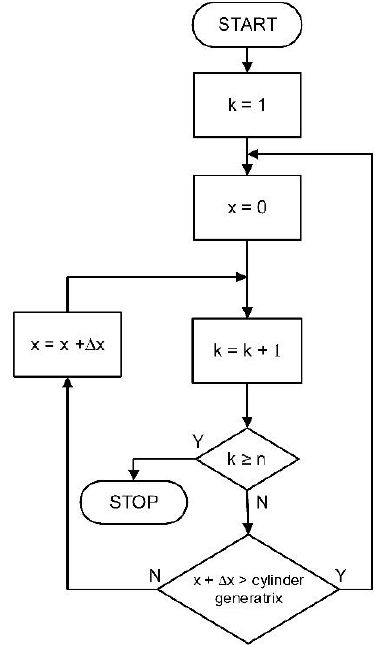
Figure 14. Flowchart of a systematic algorithm for inductor movement, where x is a coordinate along the cylinder generatrix, k is an experiment step, P is heat power, and n is the maximum of experimental